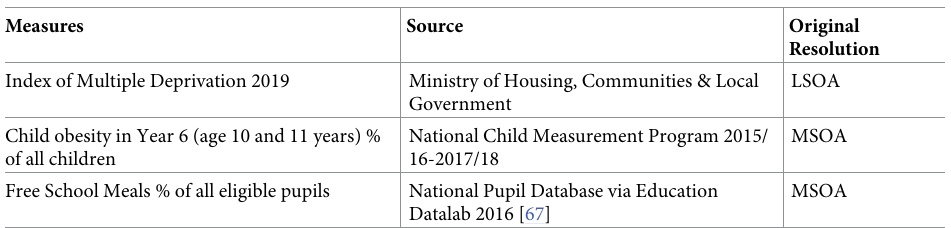
Table 3. Validation